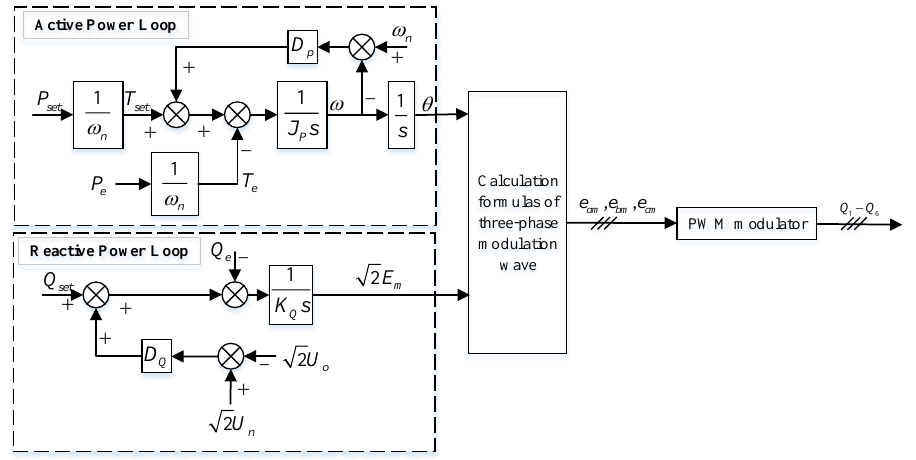
Figure 11. VSG control block diagram.